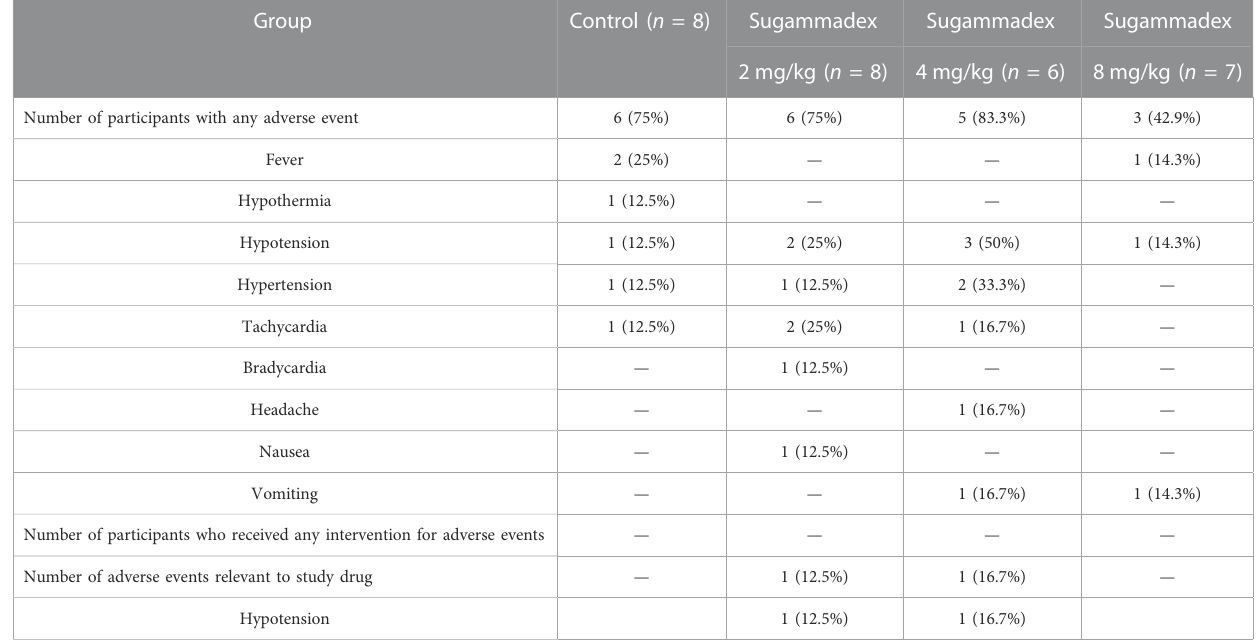
TABLE 4 Summary of adverse events after sugammadex administration.